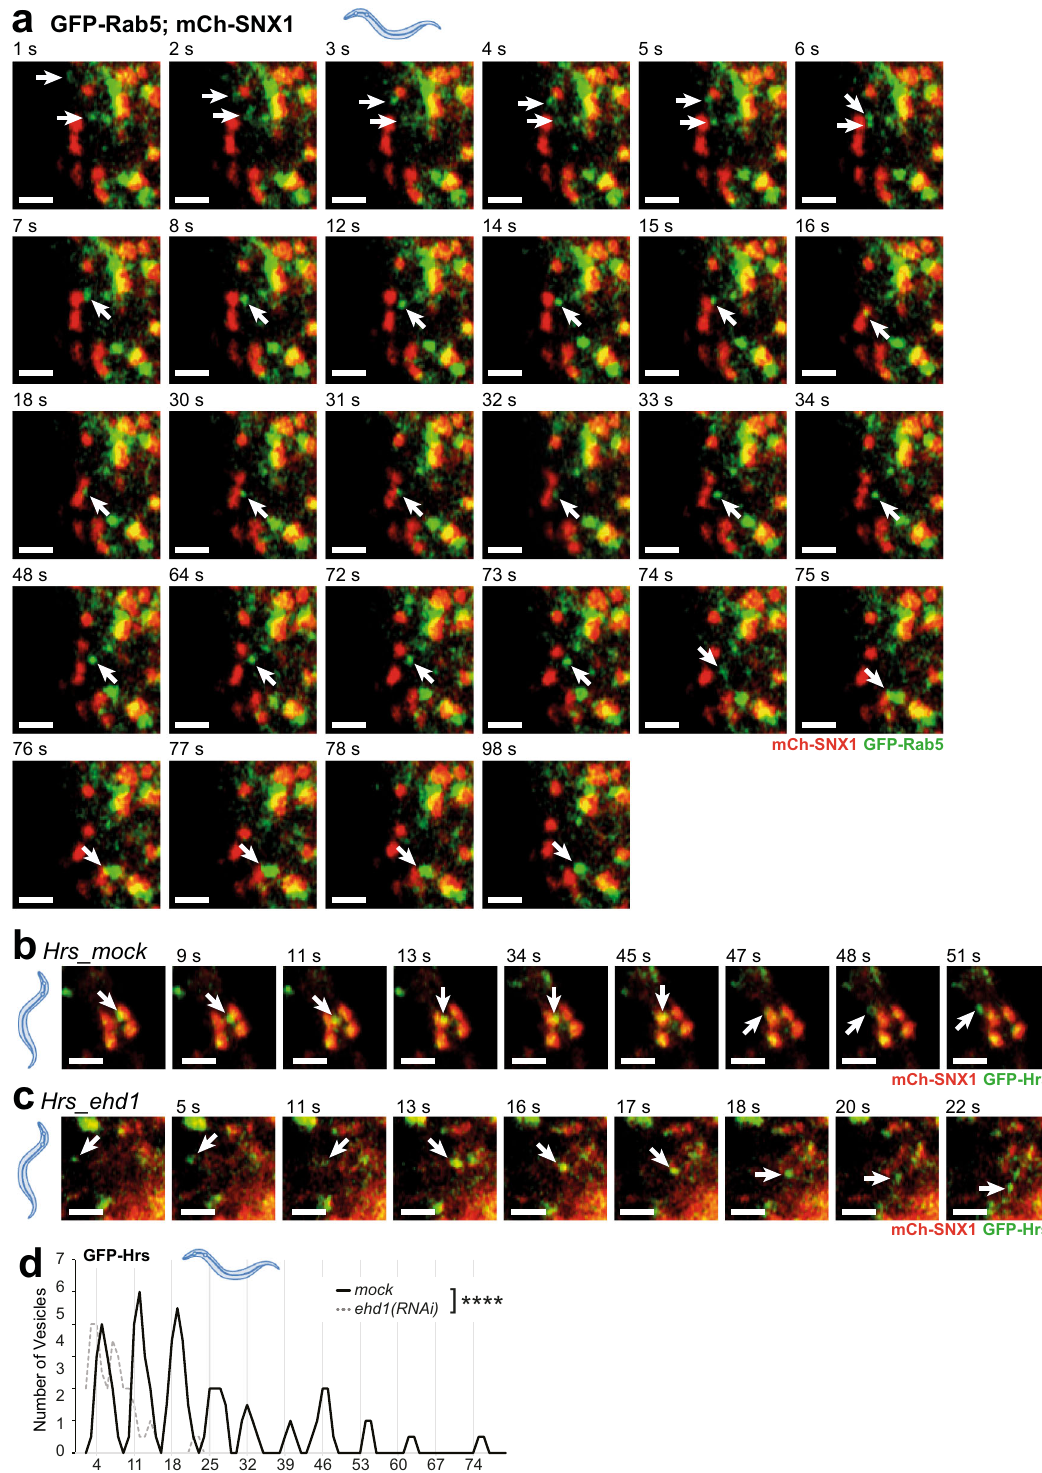
Fig.2|Rab5vesiclesarefusinganddoingkiss-and-runonthewaytothesorting endosome, probably while carrying ESCRT-0 cargo adaptors. a Movie stills for GFP-Rab5-positive vesicles (arrows) fusing, then docking on mCherry-SNX1 com- partment (kiss-and-run for 18s) and fi nally fusing with a larger sorting endosome (with GFP-Rab5 and mCherry-SNX1 domains) ( n =53, kiss-and-run, n =19 fusing). Scale bar: 2 µ m. b Cargo adaptor ESCRT-0 subunit Hrs moves with vesicles that perform kiss-and-run on SNX1 compartments ( n =67) (movie stills from